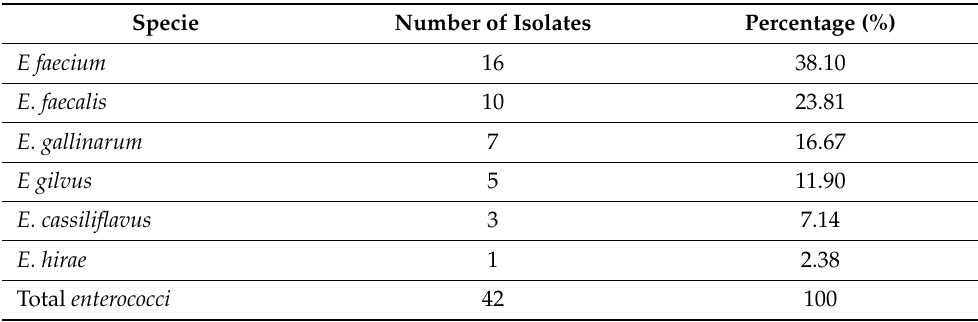
Table 3. Number and percentage of enterococci isolated from Kanamycin Esculin Azide agar in fresh turkey